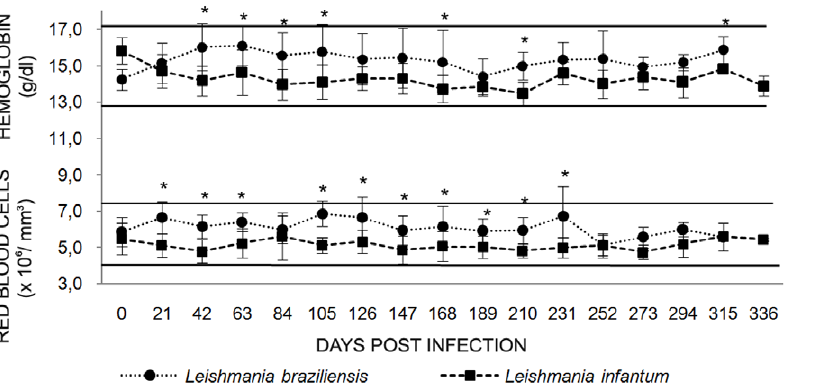
Figure 1. Kinetics of red blood cell counts and hemoglobin levels in Thrichomyslaurentius experimentally infected by Leishmania braziliensis (Lb) or Leishmaniainfantum (Li). Each point represents the mean value and standard errors. The continuous lines indicate the normal range defined by the medium values obtained for each group one-day before the inoculum and two-fold standard errors. The * indicates the significant difference between rodents infected either by L. braziliensis or L. infantum